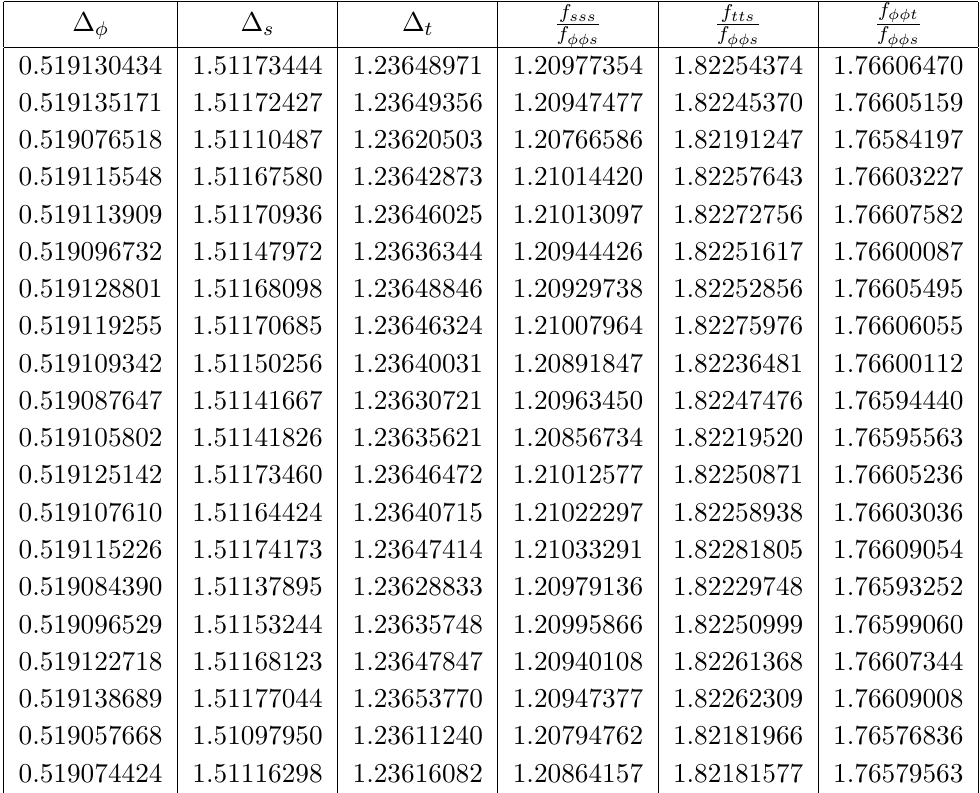
Table 1 . Allowed points in the (cid:3) = 35 island used for the extremal functional